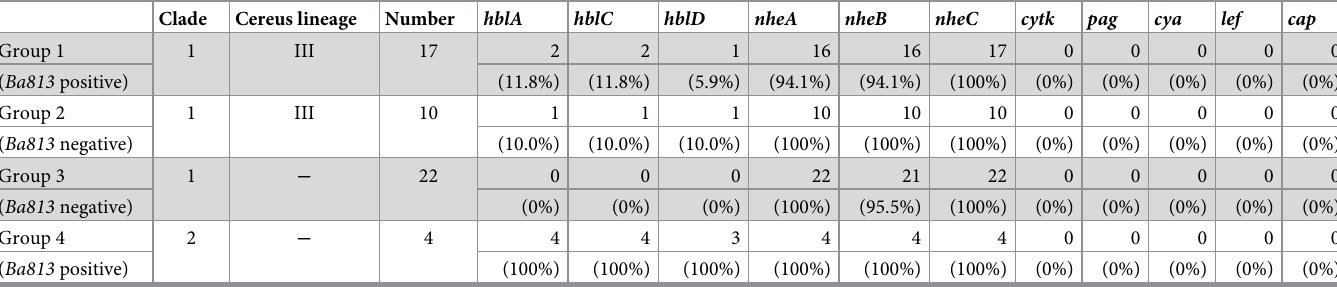
Table 1. Genes encoding pathogenic factors in B . cereus isolated from the patients with BSI.